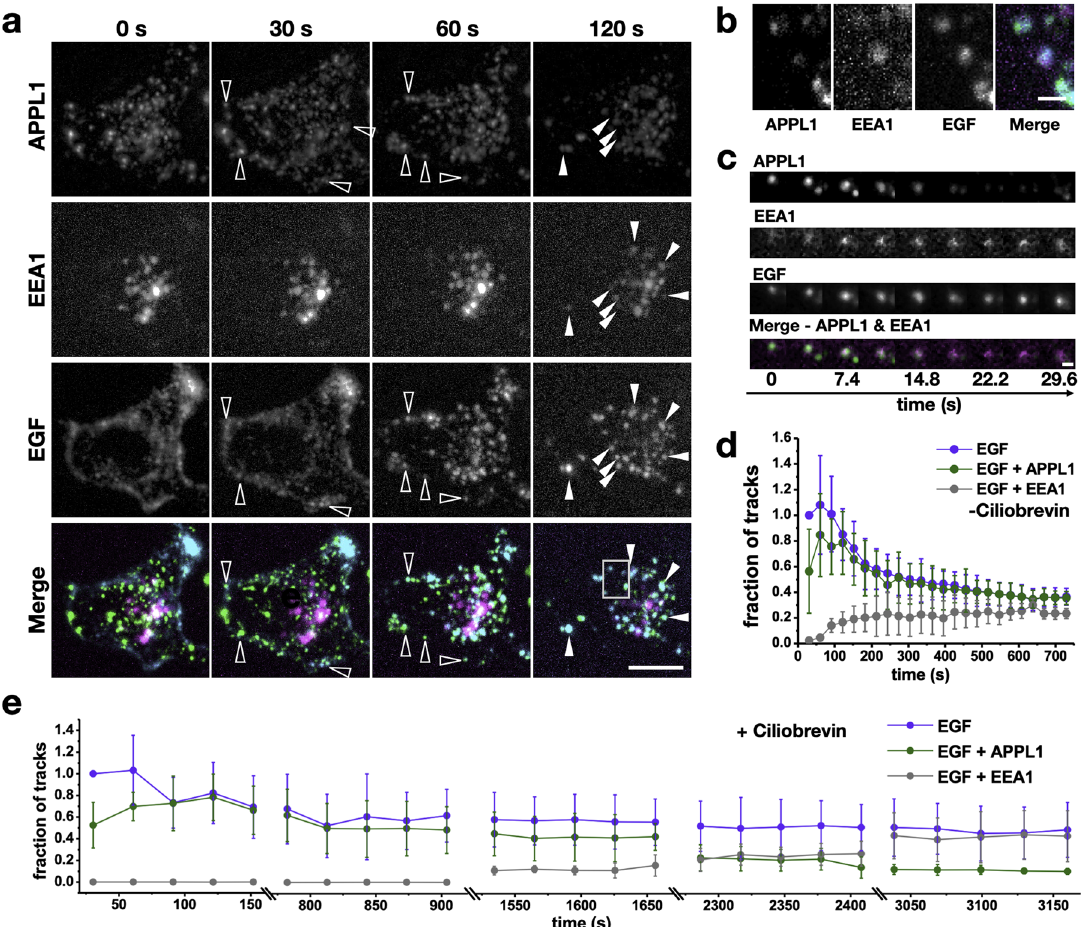
Fig. 3 APPL1-EGF endosomes mature by acquiring EEA1 and are dependent on its retrograde motility and localization to PNR. a Representative maximum intensity projections of 100 mM EGF stimulation of HeLa cells expressing APPL1-EGFP and EEA1 TagRFP-T (magenta). Hollow arrows point at a few examples of APPL1 and EGF colocalization and the solid arrows point at APPL1-EEA-EGF1 triple or EEA1-EGF double positive endosomes. Scale bar = 15 µ m. b A zoomed view of APPL1-EEA1-EGF triple positive endosomes in the boxed region in ( a ). Scale bar = 0.5 µ m. c An EGF-APPL1 double positive endosome undergoing maturation by conversion to an EGF-EEA1 positive endosome. Scale bar = 0.2 µ m. d Graph of fraction of EGF tracks positive for APPL1 and EEA1. Error bars indicate standard deviation ( n = 6 cells). e Same plot as ( d ) for cells treated with 50 µ M ciliobrevin ( n = 5 cells). Double lines on the x -axis indicate breaks in